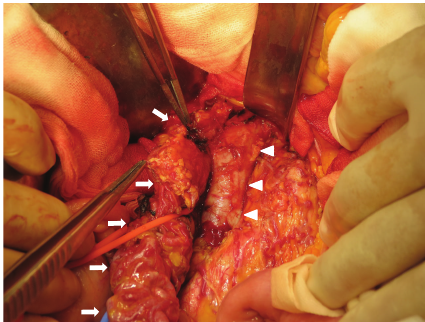
Figure 4: The right infundibulopelvic ligament including intravenous leiomyoma. The right infundibulopelvic (IP) ligament (arrows) including intravenous leiomyoma that arose from the uterus formed a connection to IVC (arrowheads) along the route of the right ovarian vein. A plexus of small arteries which were detected on arterial phase CT (Figures 1 and 2) was seen on the surface of the IP